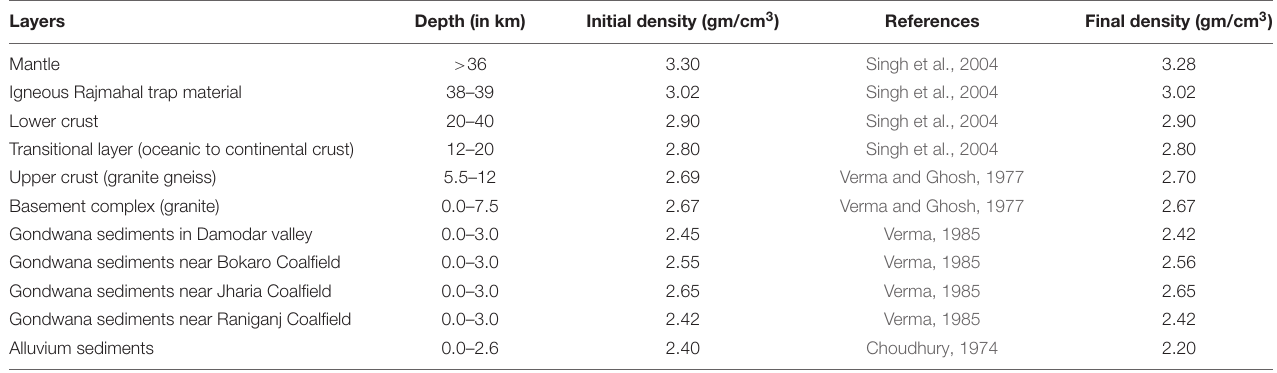
TABLE 1 | Density used in the 2D gravity modeling.